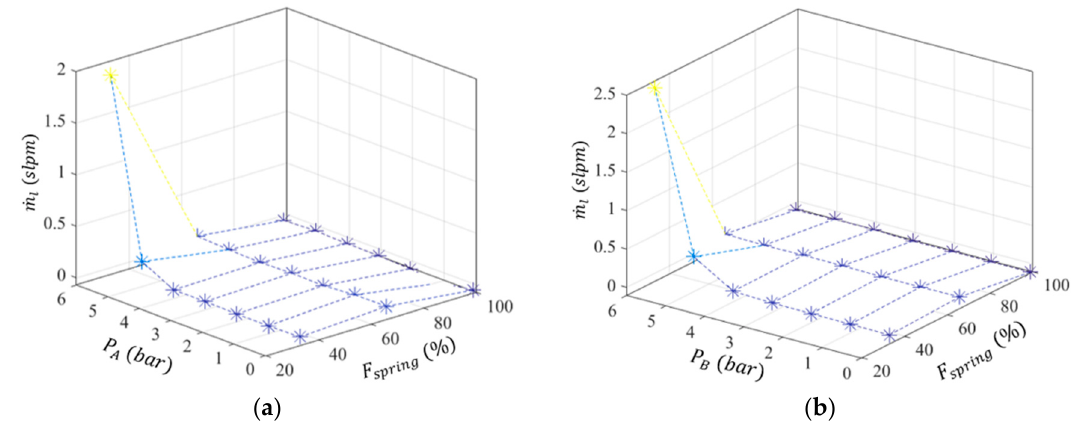
Figure 10. Leakage measurements with force adjustment: ( a ) chamber A; ( b ) chamber B.